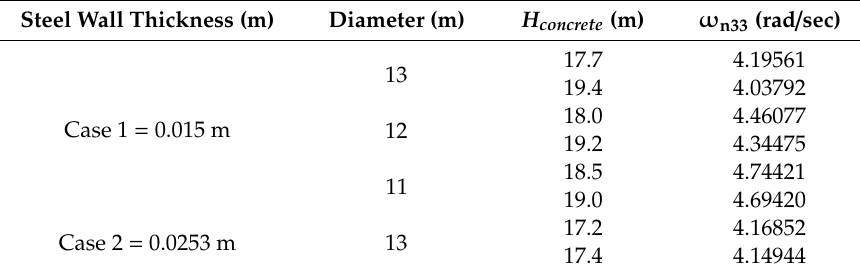
Table 8. Heave natural frequencies of optimized designs.